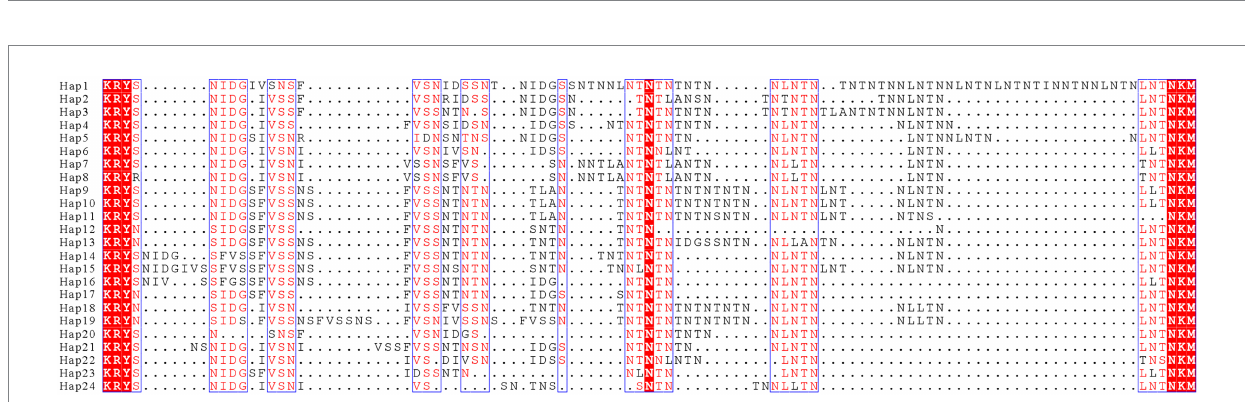
FIGURE 9 Alignment of the representative Rpb1 protein sequences of 24 haplotypes obtained from nine Pseudokabatana alburnus isolates. Dots depict gaps. The red outlined highlighted the identical amino acid. Mostly conserved or similar amino acid are shown in red with the blue boxes.